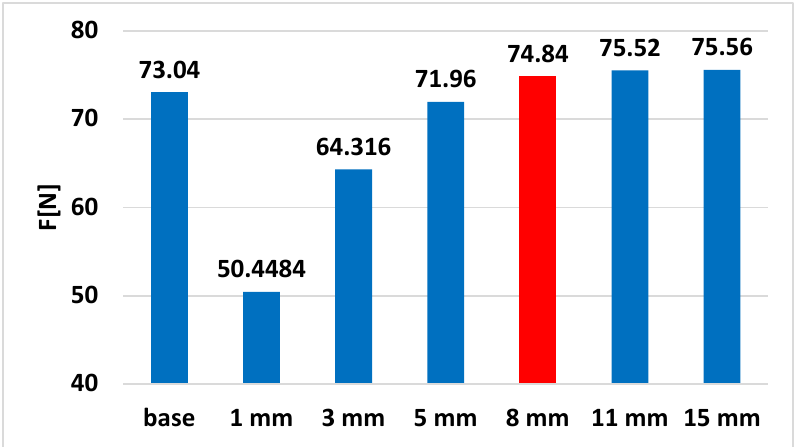
Figure 13. The variation of the propulsion force read in section 3 obtained through numerical simulations for the variation of section 5.